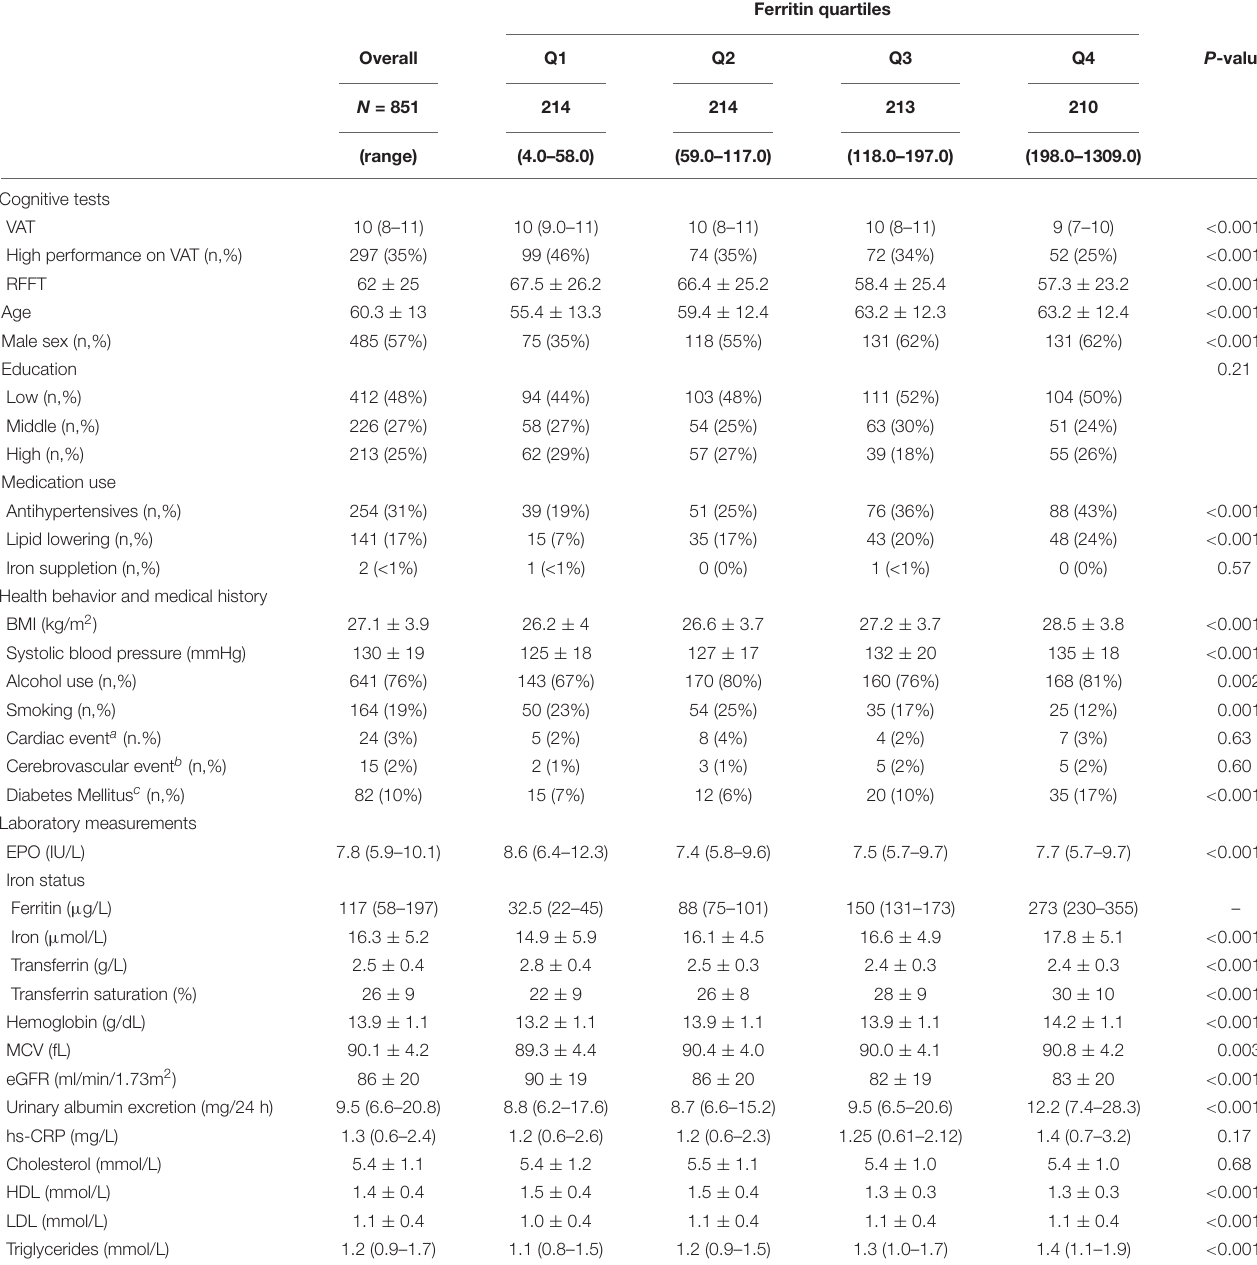
TABLE 2 | Baseline characteristics of 851 community-dwelling subjects according to quartiles of ferritin